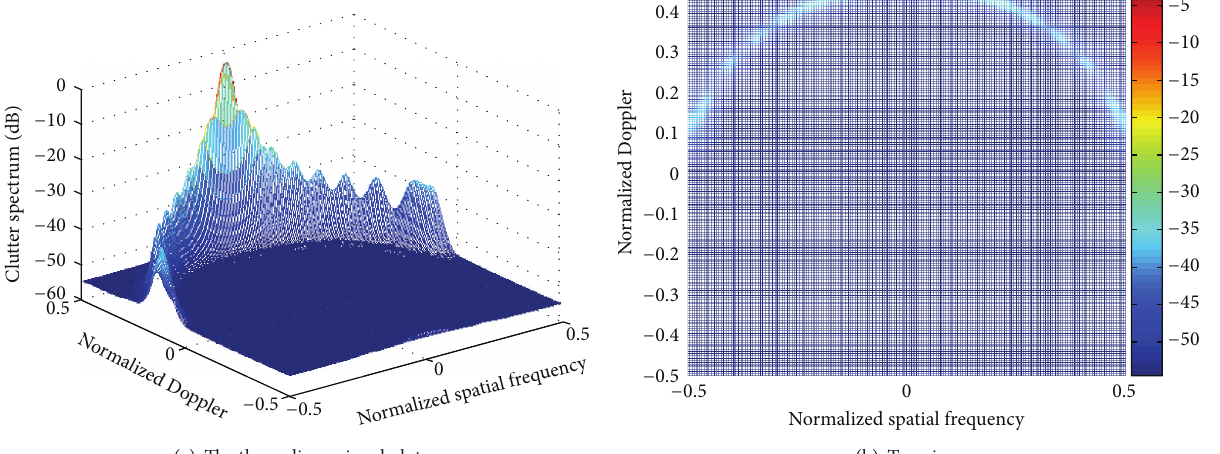
Figure 3: Forward-looking clutter spectrum.